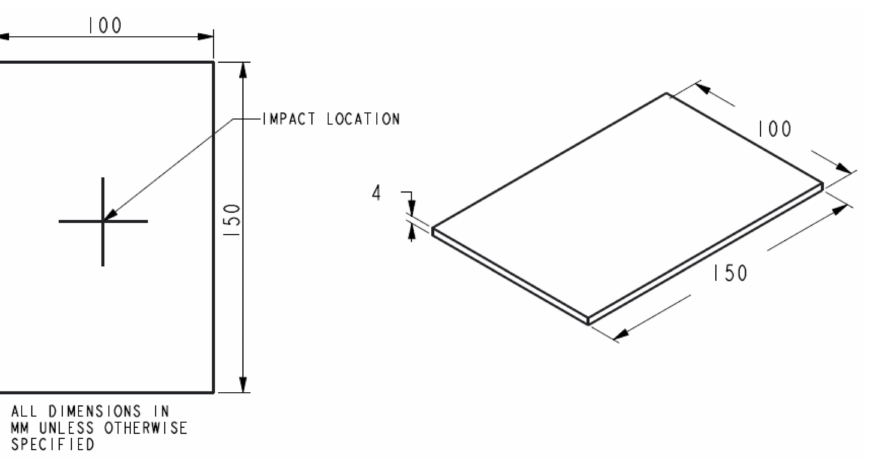
Figure 1. Drop-weight impact test specimen according to ASTM D7136/D7136M